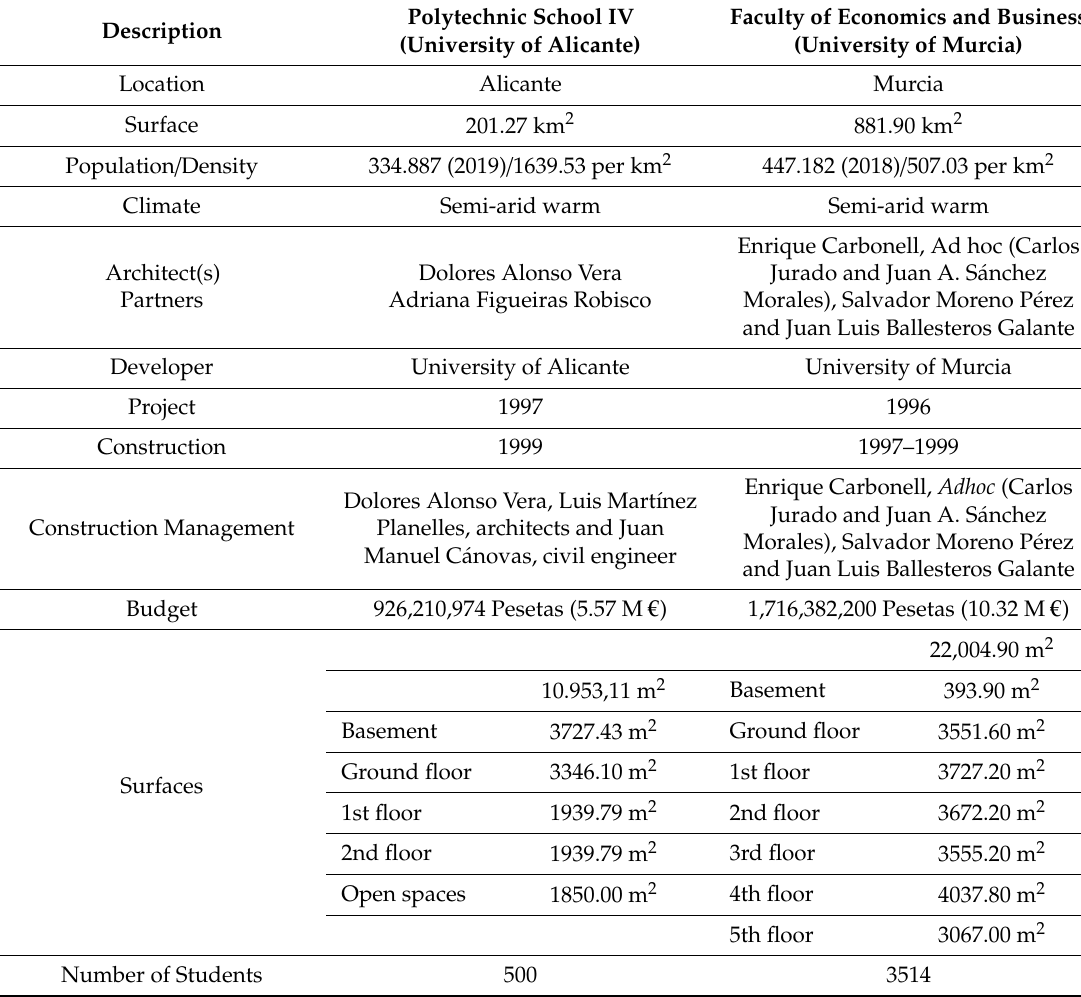
Table 2. Technical sheet for the HPS IV of the University of Alicante and the FEB of the University of